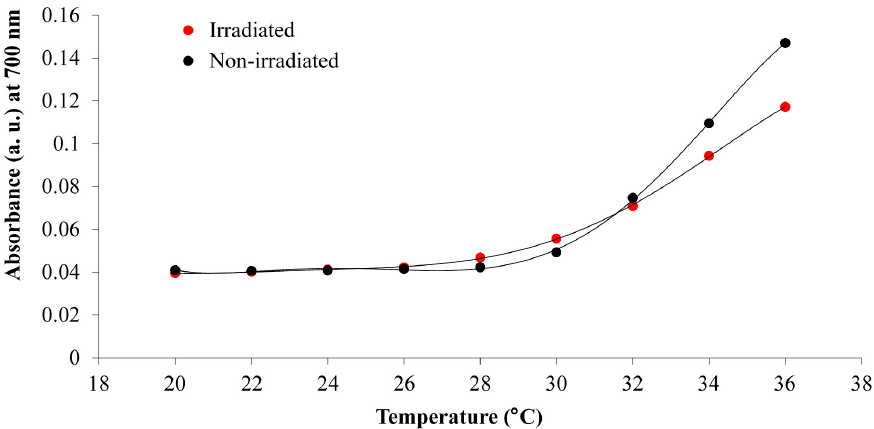
Figure 4. Comparison of the absorbance values at 700 nm between the non ‐ irradiated and white light irradiated 0.1% w/w p(NiPAAm ‐ BSP ‐ AA) linear copolymer solutions at different temperatures.